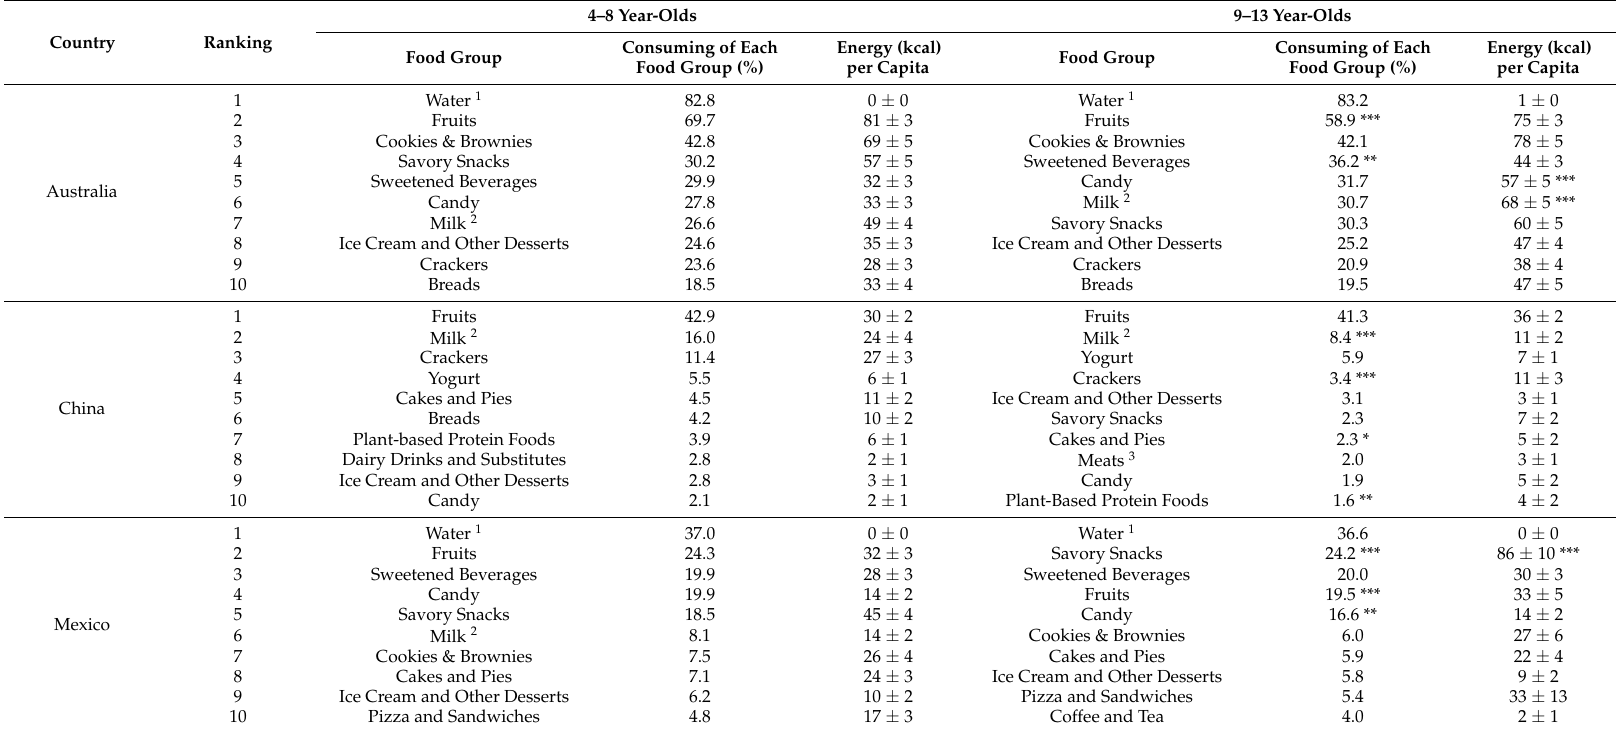
Table 3. Top 10 of the most frequently reported foods and beverages consumed during snacking and their energy contributions among children in Australia, China, Mexico, and the